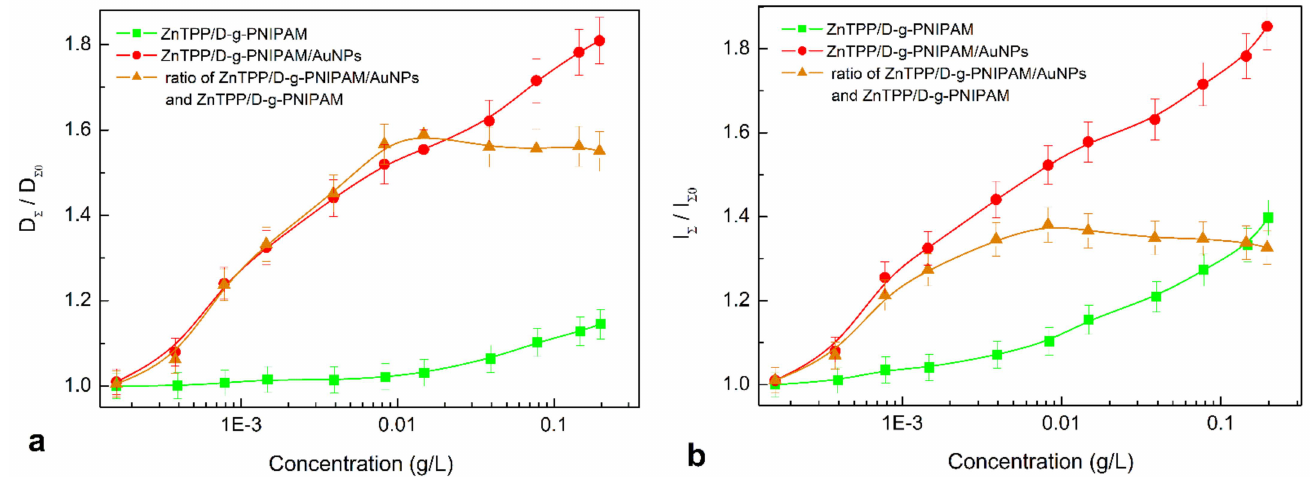
Figure 5. The dependence of normalized total optical density ( a ) and FL total intensity ( b ) of ZnTPP in ZnTPP/D-g-PNIPAM (squares) and ZnTPP/D-g-PNIPAM/AuNPs (circles) aqueous solutions on the concentration of polymer and gold respectively. Triangles—the dependence of ratio of optical densities and, respectively, FL intensities of ZnTPP/D-g-PNIPAM/AuNPs and ZnTPP/D-g- PNIPAM on the concentration of gold characterizing an impact of Au NPs on ZnTPP FL in the hybrid nanosystem. The optical density and FL intensity are normalized to the respective values for ZnTPP in aqueous solution. ZnTPP concentration is 0.001